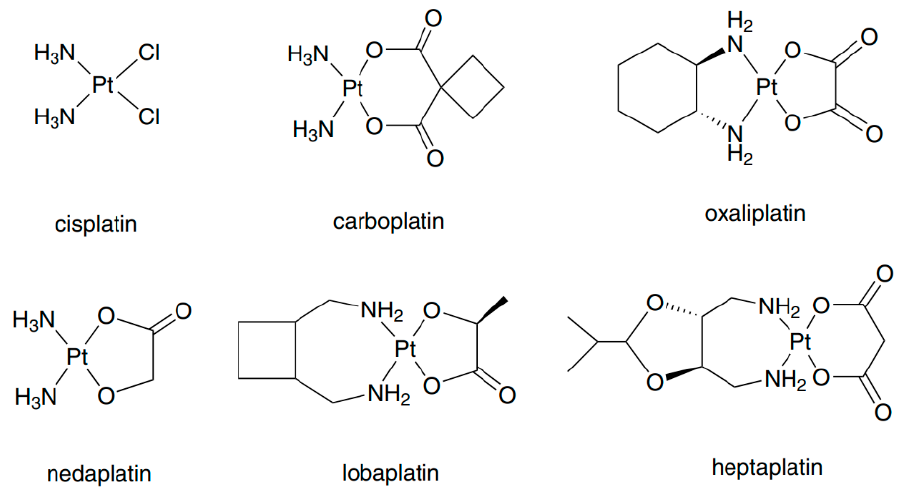
Figure 1. Structure of clinically used platinum anticancer drugs. Reprinted with permission from [6]. Copyright Springer 2016. Table 1. Pharmacokinetics of cisplatin and its analogues following intravenous infusion. Reprinted with permission from [19]. Copyright Springer